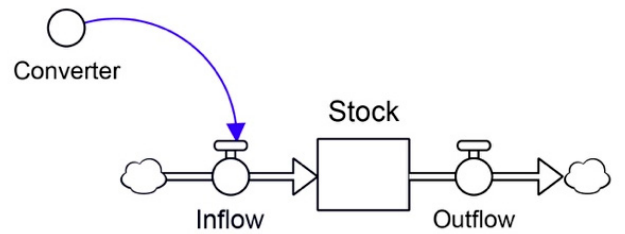
Figure 4. Stock and Flow general